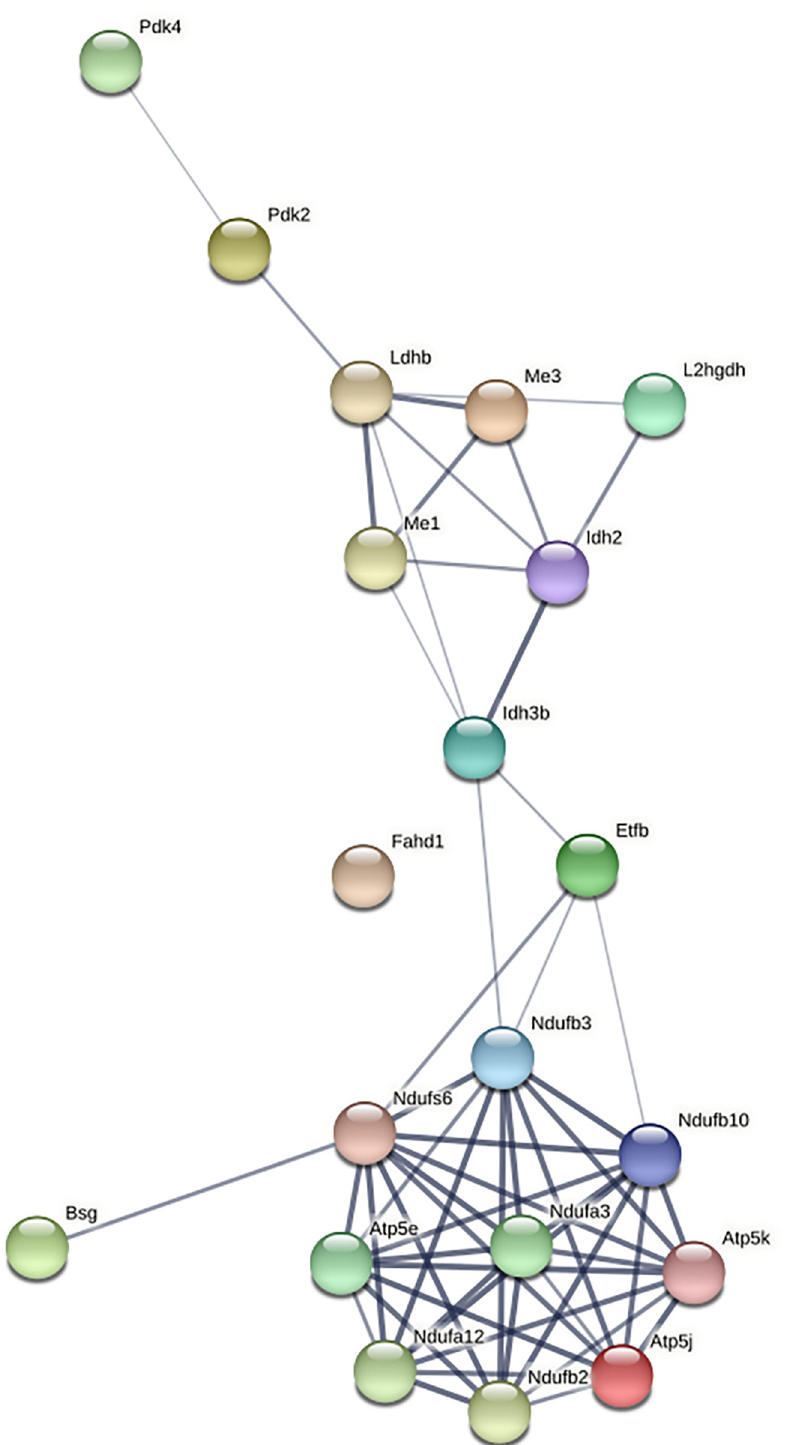
Fig 2. Network pathway generated by ProteoMill software to elucidate interaction of skeletal muscle proteins between TCA cycle and electron transport chain: See Table 2 for the detailed list of proteins present in the network pathway. Colour of each node indicates the differential expression of the respective protein down-regulated and up-regulated, respectively, in the treatment group (80ppm of NaF for 15 days and80ppm of NaF for 60 days vs control of each